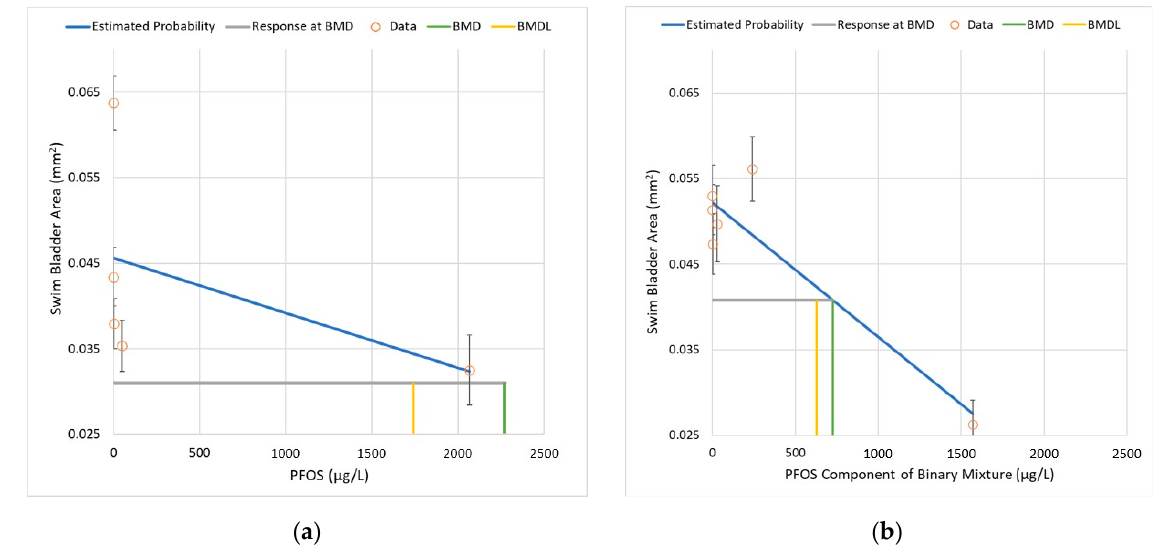
Figure 7. Linear D–R models fitted to PFOS datasets for ( a ) the component study and ( b ) the binary mixture study, showing differences in the slopes and intercepts. The linear D–R model parameters are ( a ) component study: intercept = 0.0456 mm 2 , slope = − 6.45 × 10 − 6 mm 2 per µg/L, and control group mean = 0.064 mm 2 ; and ( b ) binary mixtures study: intercept = 0.0522 mm 2 , slope = − 1.57 × 10 − 5 mm 2 per µg/L, and control group mean = 0.053 mm 2 .